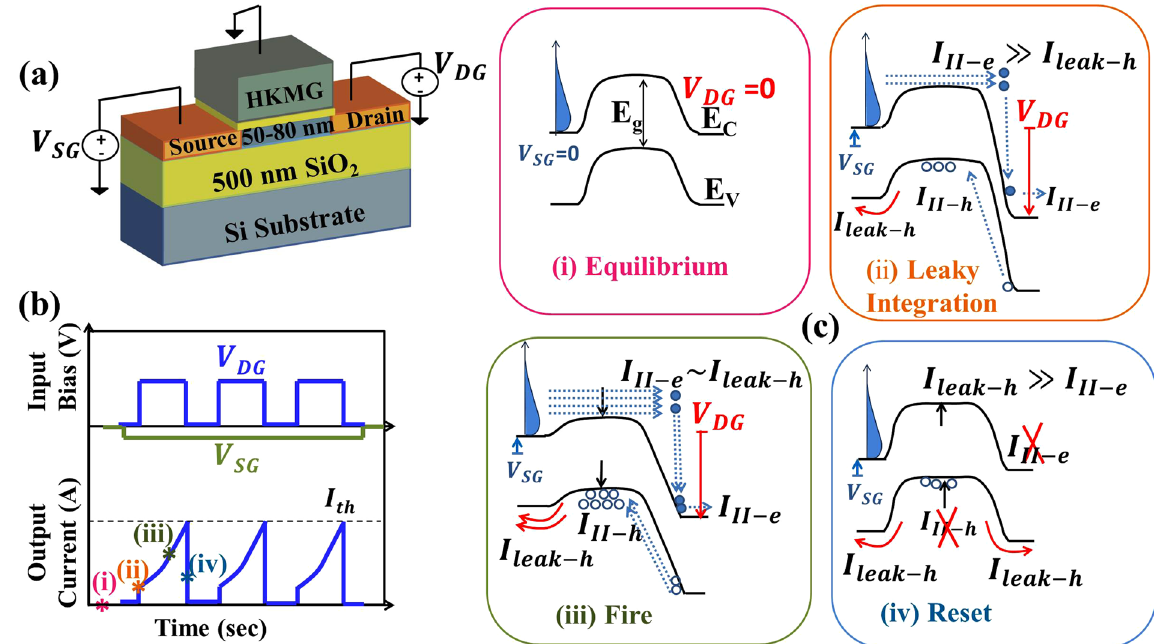
Figure 3. ( a ) Device schematic with biased terminals, ( b ) Input biasing scheme (V SG (t),V DG (t)) with expected output (I D (t)), (c-i) Equilibrium band diagram. (ii) Electron hole pair generation due to impact ionization (“integrate”) increases holes in well, (iii) Barrier lowering due to stored holes in the potential well. Also, the